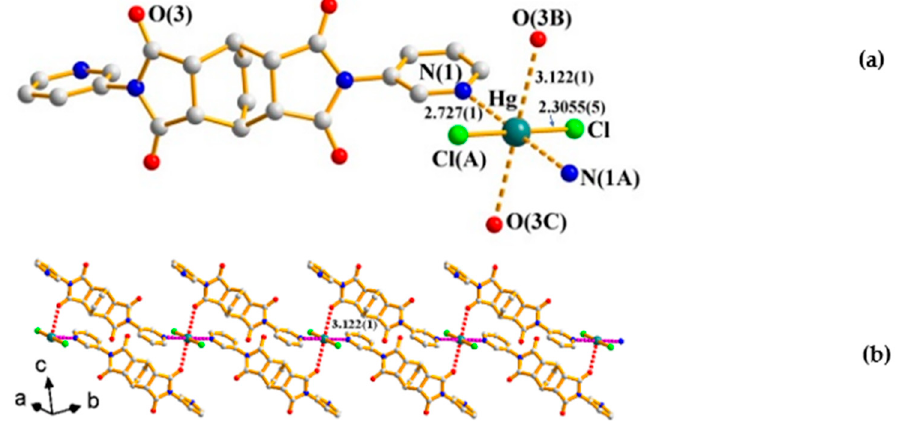
Figure 2. ( a ) Coordination environment of Hg(II) ion in 1 . Symmetry transformations used to generate equivalent atoms: (A) − x, − y + 2, − z + 1; (B) − x + 1, − y + 1, − z + 1; (C) x − 1, y + 1, z. ( b ) A depiction showing the 1D supramolecular structure of 1 .